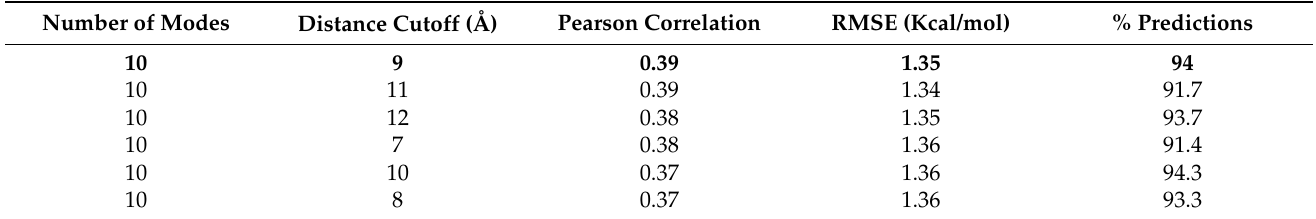
Table 1. Predictive performance of PSP-GNM for different distance cutoffs evaluated on the S2298 dataset. For all calculations, only the top 10 low-frequency modes were used. % Predic- tions is the percentage of mutations in the S2298 dataset with a calculated ∆∆ G. The best performance is shown in bold.